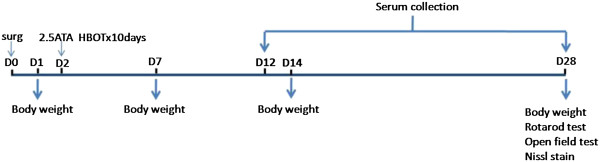
Experimental design.